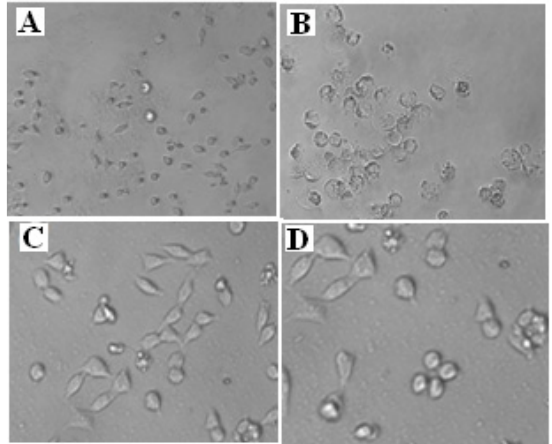
Figure 4. Images of in vitro cytotoxicity screening against HeLa (Human cervical cancer cell line) for Control ( A ), Positive control ( B ), Compound 6c ( C ) at 80 µg/mL concentration, Compound 6f ( D ) at 80 µg/mL concentration. Table 11. In vitro cytotoxicity study of the synthesized compounds 6c and 6f .